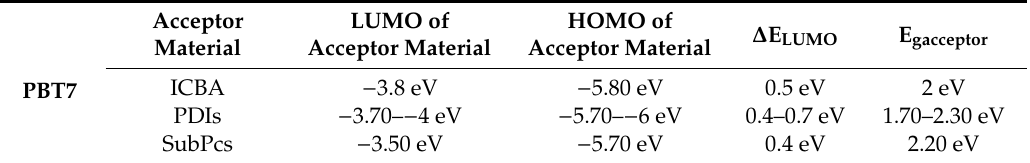
Table 3. Common organic materials typically used as electron acceptors with PTB7 as the electron donor in organic solar cells. Included are the energy levels of the HOMO and LUMO levels, the ∆ E LUMO and the E g value of each acceptor